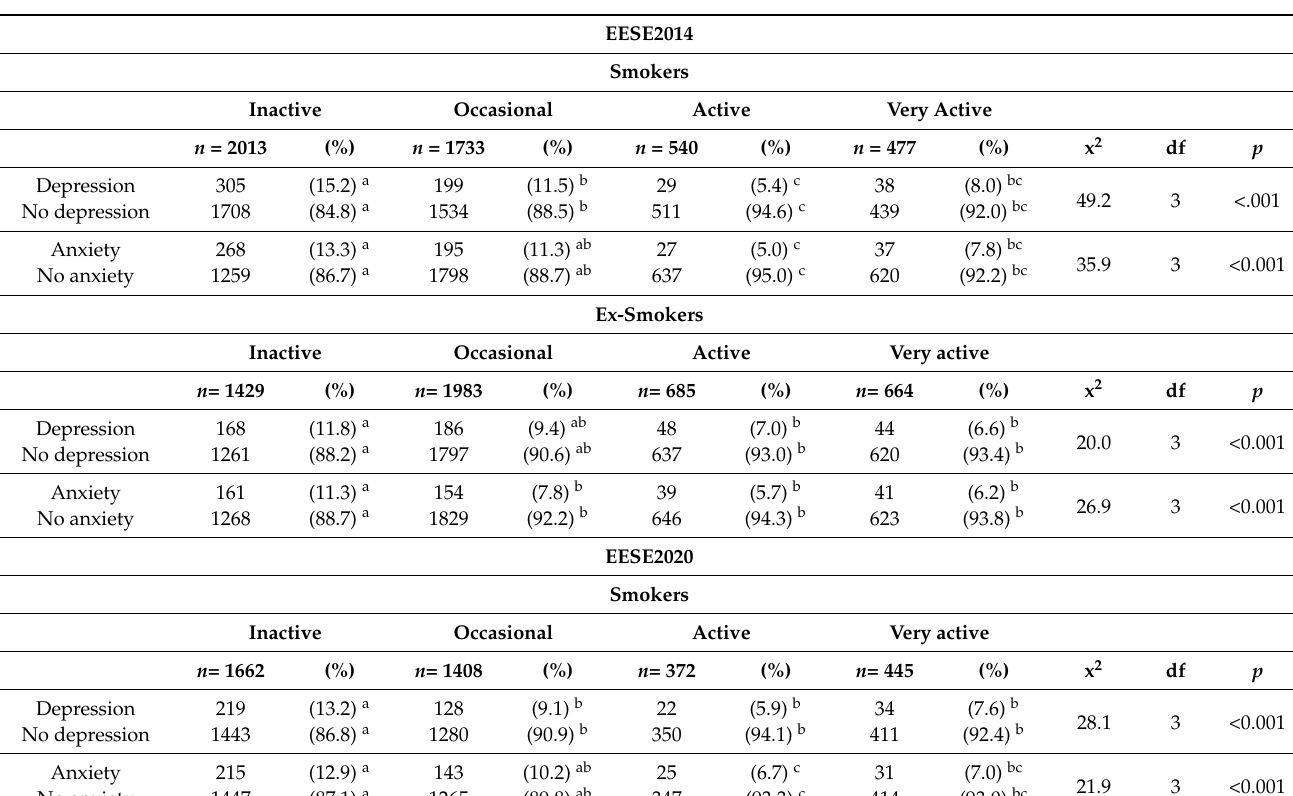
Table A2. Prevalence of depression and anxiety in Spanish smokers and ex-smokers according to their frequency of physical activity: EESE2014 and